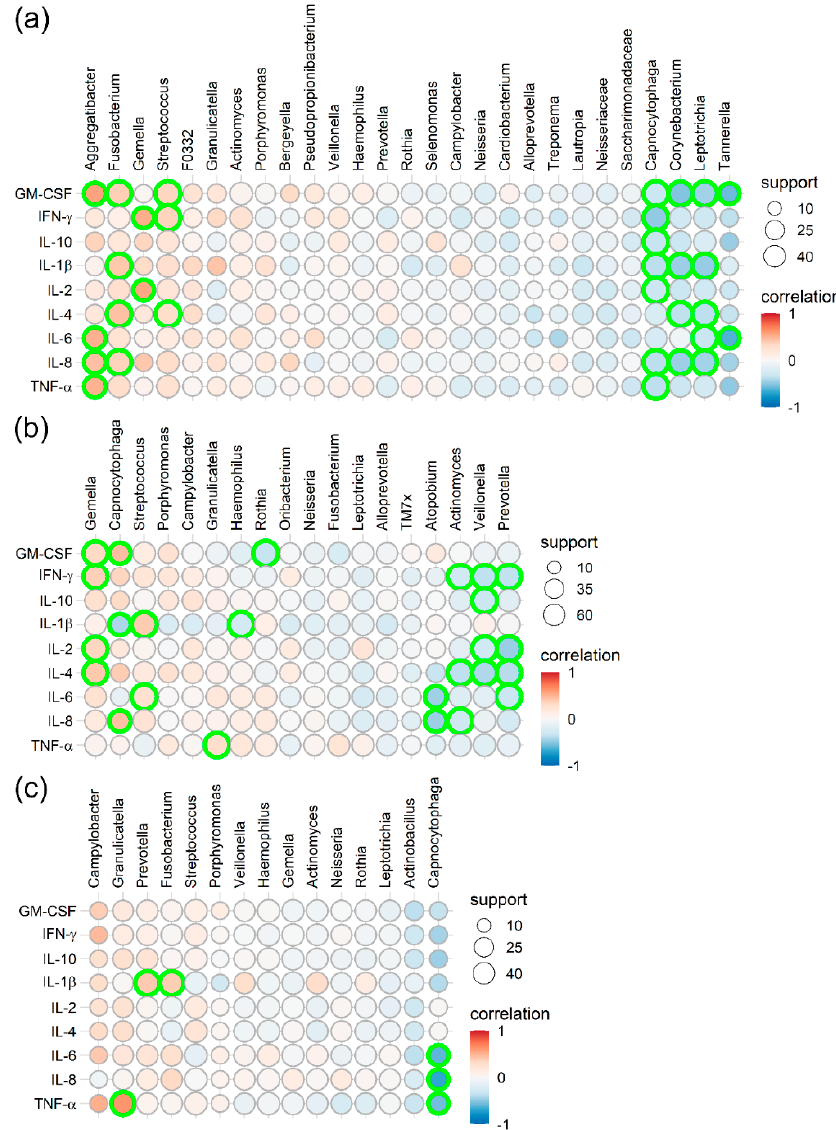
Figure 6. Pearson correlation plot between the cytokine concentrations and microbial composition (genus level) are given for the defined metaniches: ( a ) “plaque and gingival crevicular fluid” (P-GCF), ( b ) “saliva, tongue and hard palate” (S-T-HP) and ( c ) “cheek-sublingual” (C-U). The cytokines GM-CSF, IFN- γ , IL-10, IL-1ß, IL-2, -4, IL-6, IL-8, and TNF are given vertically on the left side, while genera are indicated horizontally on top of each figure. A colour key was used for the strength of correlation, ranging from highly positive (+1, red) to no correlation (0, white) to highly negative ( − 1, blue). The number of samples on which the results are based is depicted by the size of the circles, with a minimum of 10 and a maximum of 40 or 60 samples per metaniche. Shown are genera with a significant Pearson correlation ( p < 0.05). Samples with significant correlation after Benjamin–Hochberg adjustment for sample size (adj. p < 0.05) were highlighted with bright green circles.